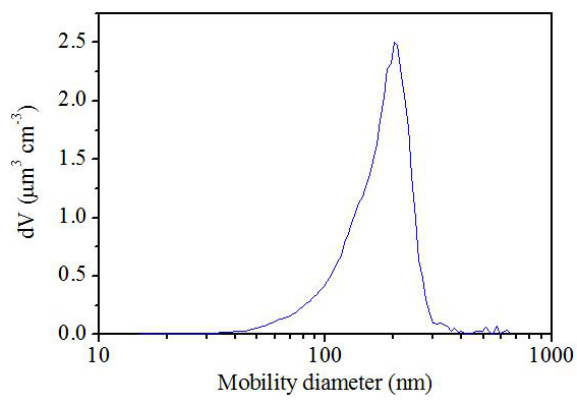
Figure 1. Size distribution of particle volume of SOA for sunflower oil at an OH exposure of 2 . 7 × 10 10 moleculescm − 3